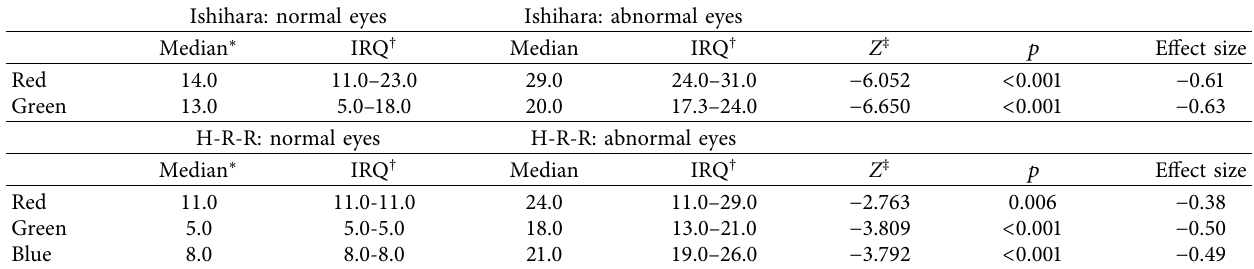
Table 5: Analysis of the K -color test results in correlation with the Ishihara and the H-R-R.